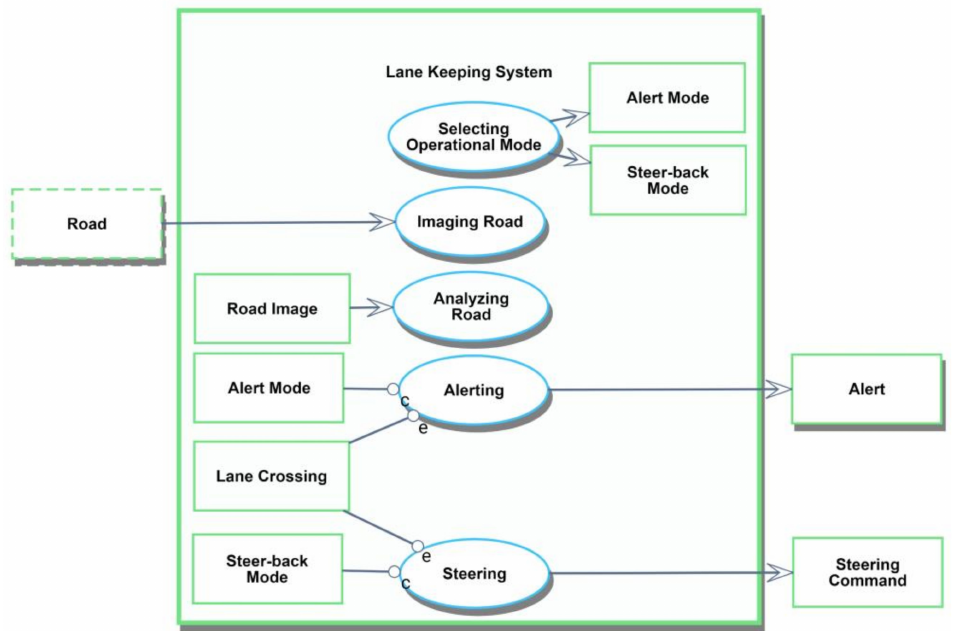
Figure 12. Lane Keeping System zooms into Alert Mode, Steer-back Mode, Road Image, Alert Mode, Lane Crossing, and Steer-back Mode, in that vertical sequence, as well as Alerting, Analyzing Road, Imaging Road, Selecting Operational Mode, and Steering (This caption is formal